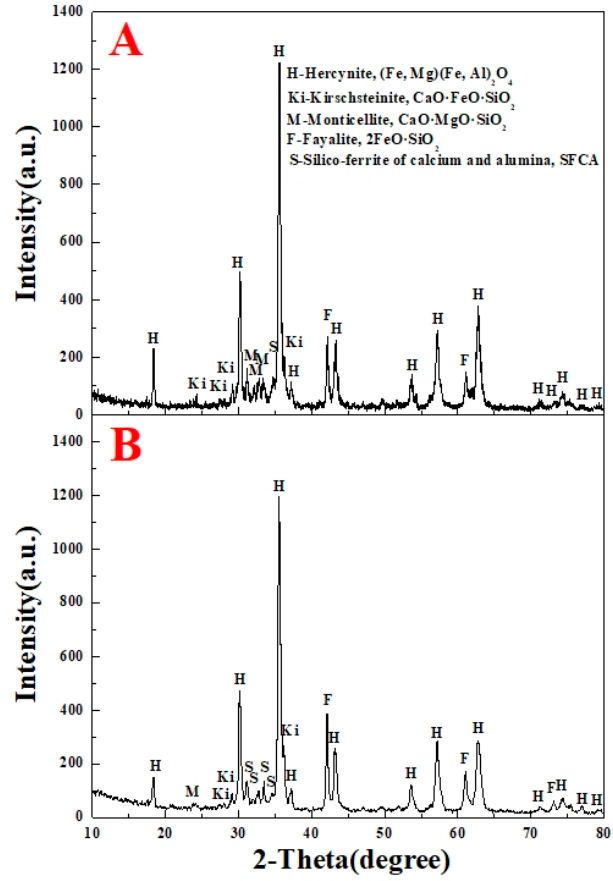
Figure 8. X-ray di ff raction patterns of the product sinter of di ff erent sintering processes ( A ) Traditional Figure 8. X-ray diffraction patterns of the product sinter of different sintering processes ( A ) sintering process, ( B ) Pressurized densification sintering Traditional sintering process, ( B ) Pressurized densification sintering process.